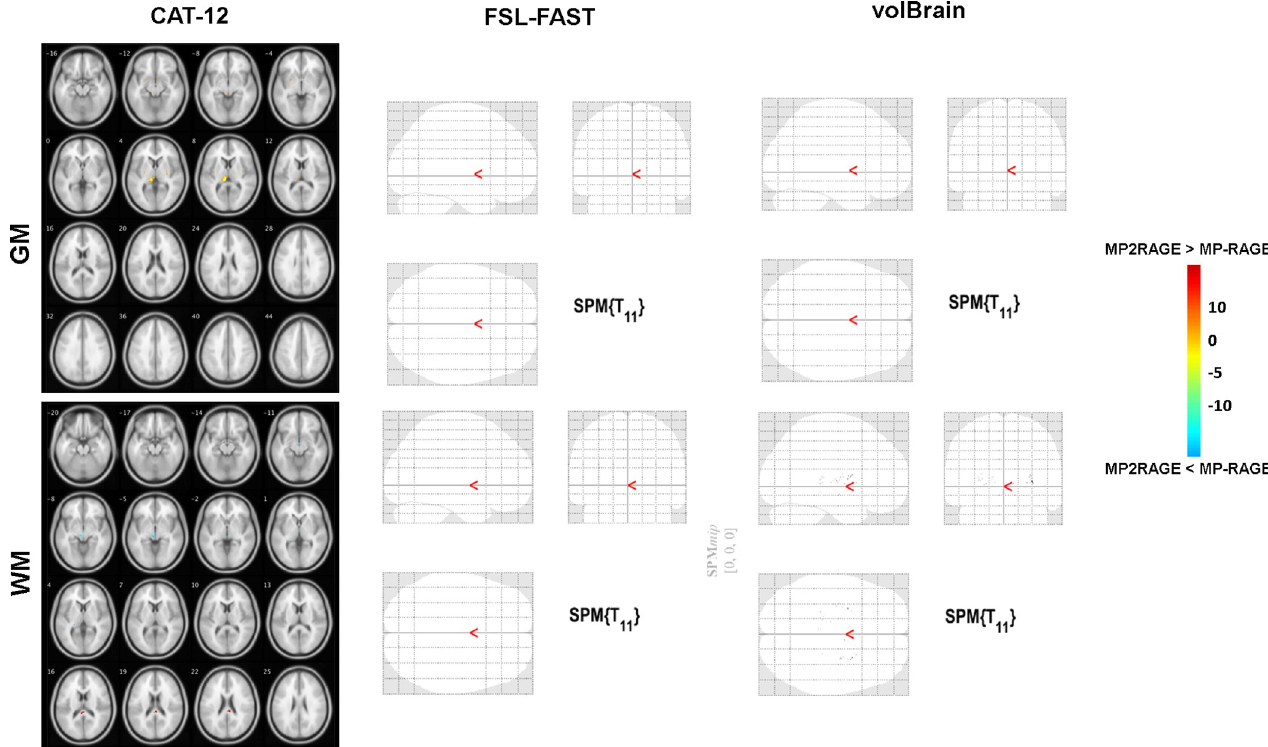
Fig 4. Sub-study VBM results of inter-modality differences in grey matter (GM) and white matter (WM) tissue probabilities differences based on tissue probability maps obtained by CAT12, FSL-FAST, and volBrain.